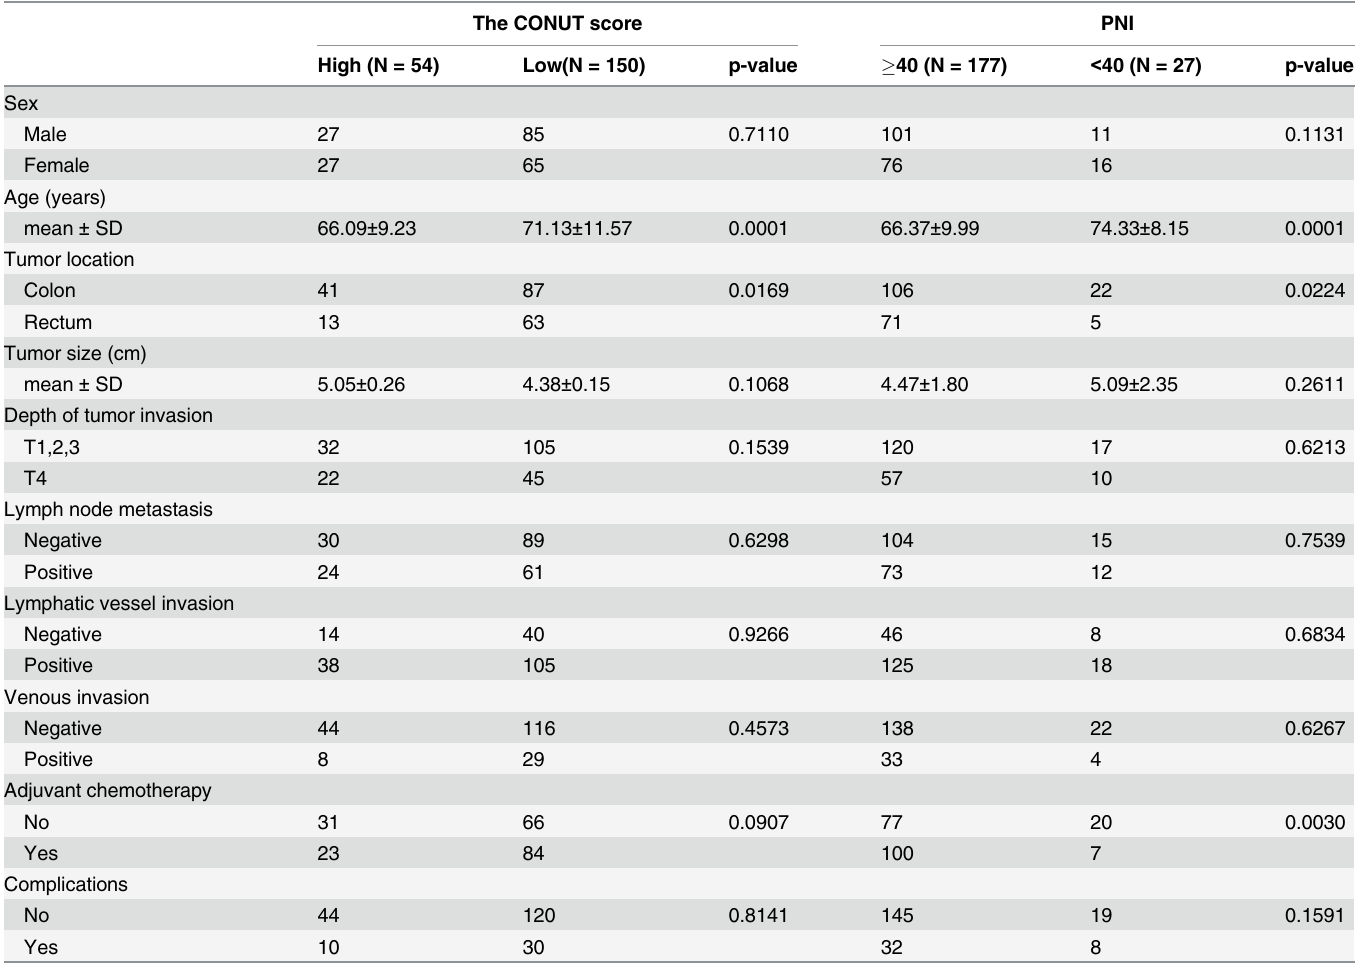
Table 2. The relationships between the CONUT score and PNI and the clinical background of the patients. The CONUT score